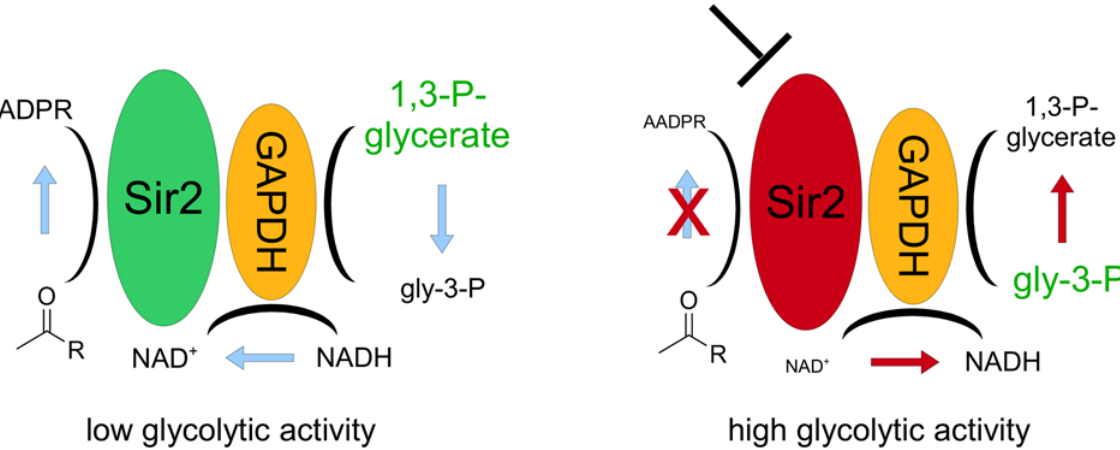
Figure 4. Metabolic interplay of GAPDH and Sir2. GAPDH catalyzes the oxidation of NADH: it generates NAD + in close proximity to Sir2. Under conditions with high glycolytic flux, higher amounts of glyceraldehyde-3-phosphate (gly-3-P) are produced, driving the backward reaction. In this case, GAPDH reduces more NAD + to NADH and inhibits the deacetylation reaction by depleting NAD + ; NAD + is a limiting factor for the Sirtuins to catalyze the formation of O-acetyl-ADP-ribose (AADPR) via the transfer of acetyl groups.